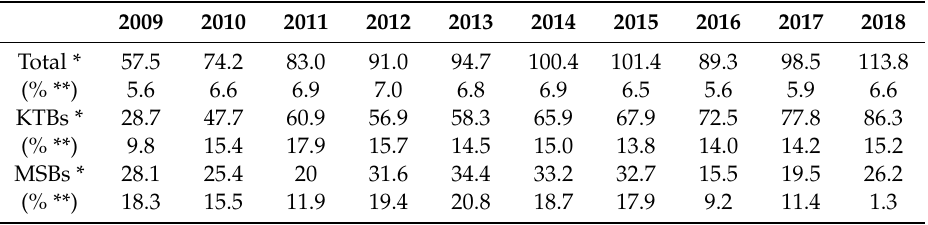
Table 1. The status of global investors’ LCY bond